Question: Express in one sentence what the figure is showing.
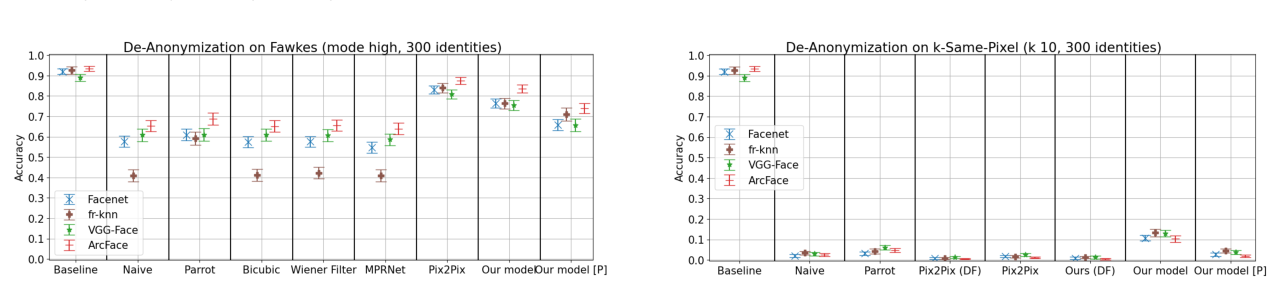
Answer: Recognition accuracy for k-Same-Pixel, given for baseline, naive, parrot, de-anon. via Pix2Pix trained on DigiFace-1M, via Pix2Pix, via our model trained on DigiFace- 1M, via our model; on 300 identities of CelebA.